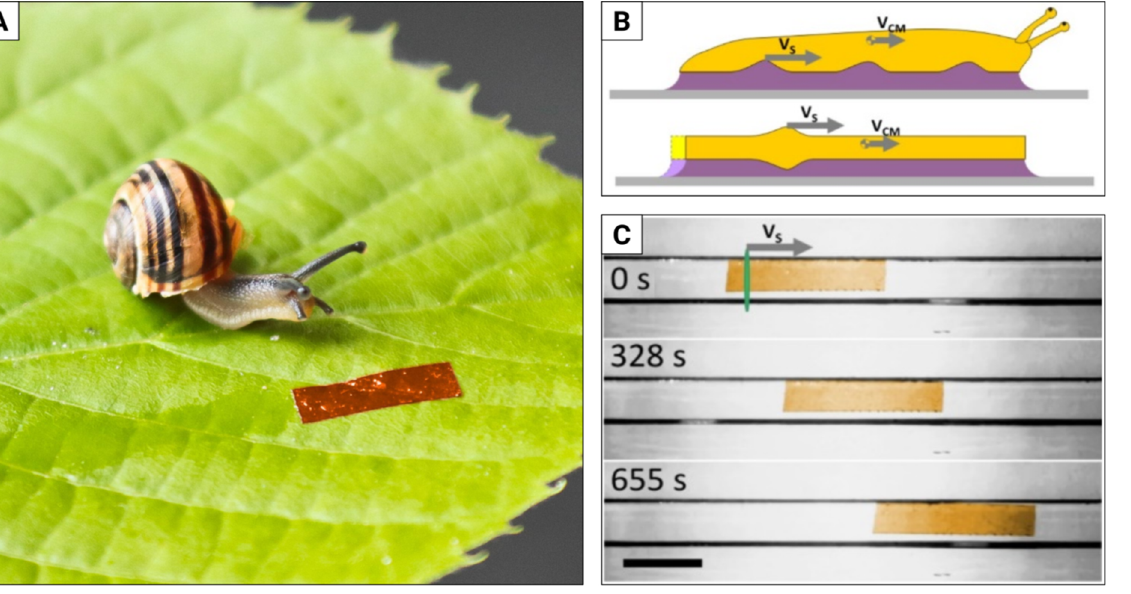
Figure 5. Light-powered snail mimicking the adhesive locomotion of terrestrial gastropods. ( A ) A garden banded-snail Cepea hortensis meets the 10 mm long light-powered snail robot (having no shell, though). ( B ) In snails and slugs, pedal waves propagate along the ventral foot contact surface with a velocity V S , propelling the animal with an average speed V CM . In a similar way, the light-induced elastomer deformation moves along the robot’s soft body (yellow) covered with an artificial mucus layer (purple). In both cases, the deformations are in fact much smaller. ( C ) Snapshots from a video with the snail robot crawling on a horizontal glass plate topped with glycerine as an artificial mucus. The average speed is 1 mm/min, the black scale bar is 5 mm long. The material contraction was of the order of 0.1 mm. Adapted from